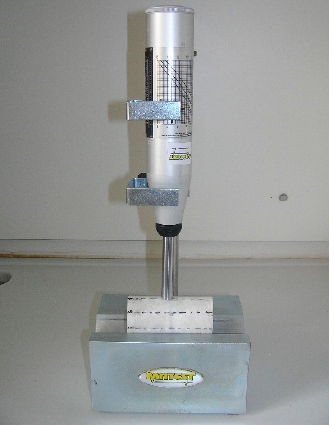
Figure 4. The Schmidt hammer rebound test.